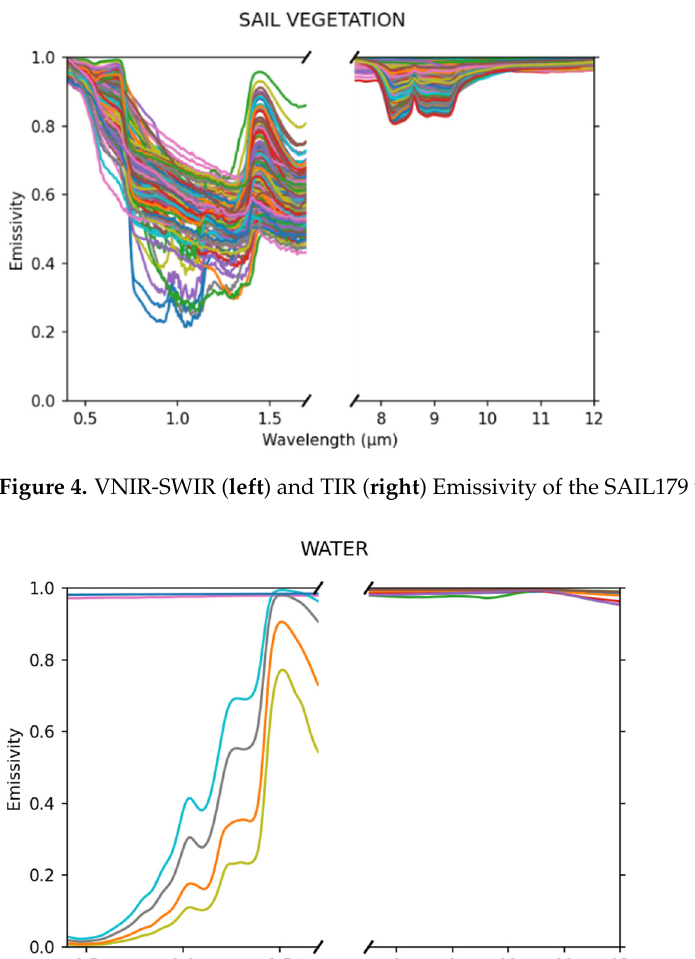
Figure 5. VNIR-SWIR ( left ) and TIR ( right ) Emissivity of the ECO6 water database.